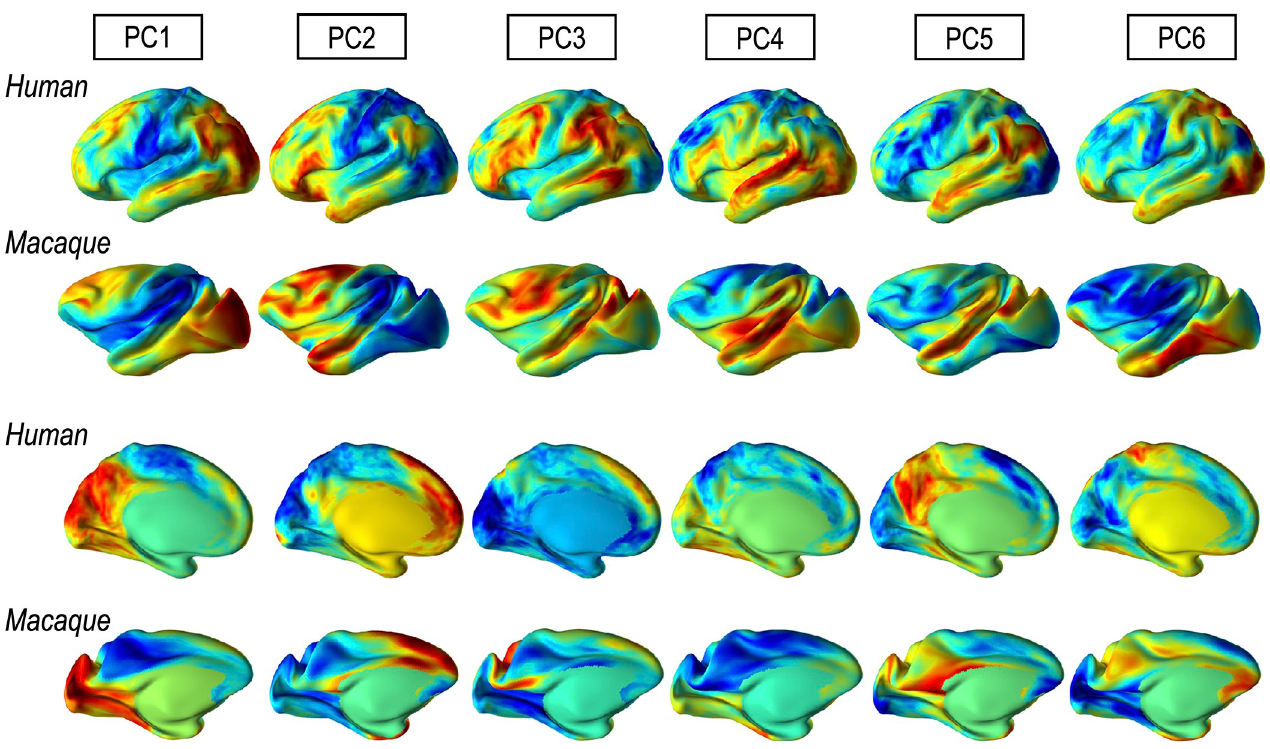
Fig 3. Six group average principal components (modes) of functional connectivity matrix for the human and macaque.